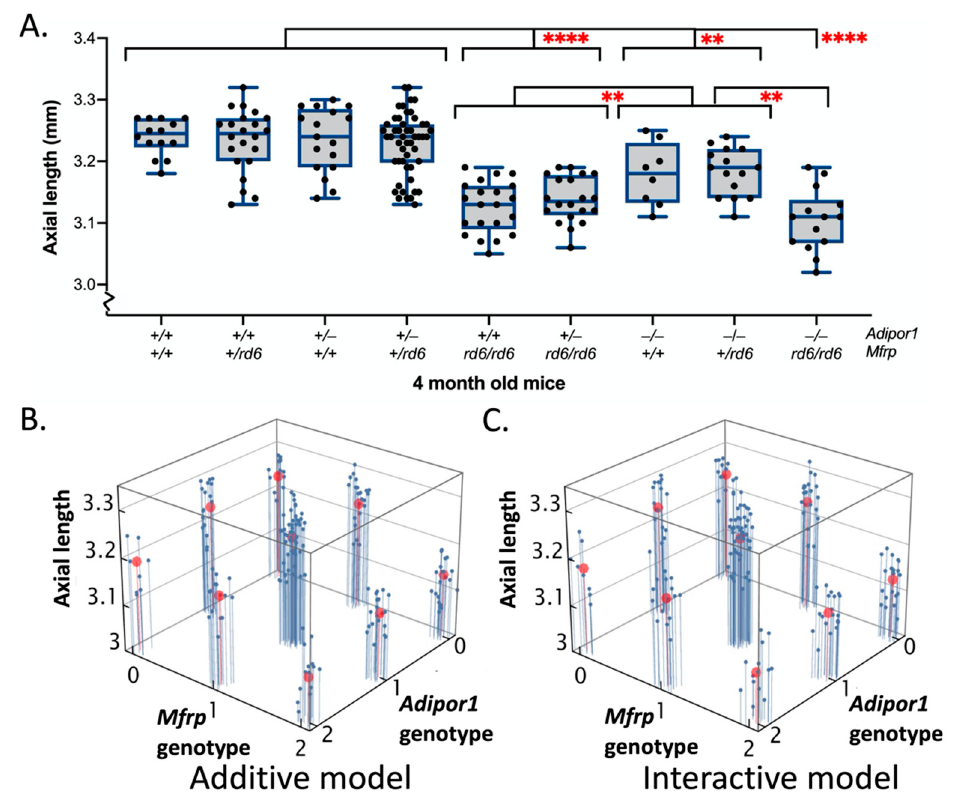
Figure 3. Axial length in 4-month-old F2 progeny obtained from an ( Adipor1 +/ − / Mfrp +/rd6 ) F1 intercross. ( A ) Using two-way factorial ANOVA, followed by Tukey’s HSD post-hoc analysis revealed statistically significant differences in axial length between different genotypic possibilities for the F2 intercross progeny. As no sex-based differences were found, data from both sexes were combined. ** p < 0.01; and **** p < 0.0001. ( B ) Linear fit model without interactions and ( C ) linear fit model with interactions, showing actual data in blue and model predictions in red. The Adipor1 and Mfrp genotypes along the two axis represent independent variables, where the alleles are scored as: wildtype—0, heterozygous—1, and homozygous—2. The axial length measurements along the third axis represent response variables. The interactive model does not have a better fit than the additive model, confirming no interaction and independent effects. n = 14–50 per genotype.